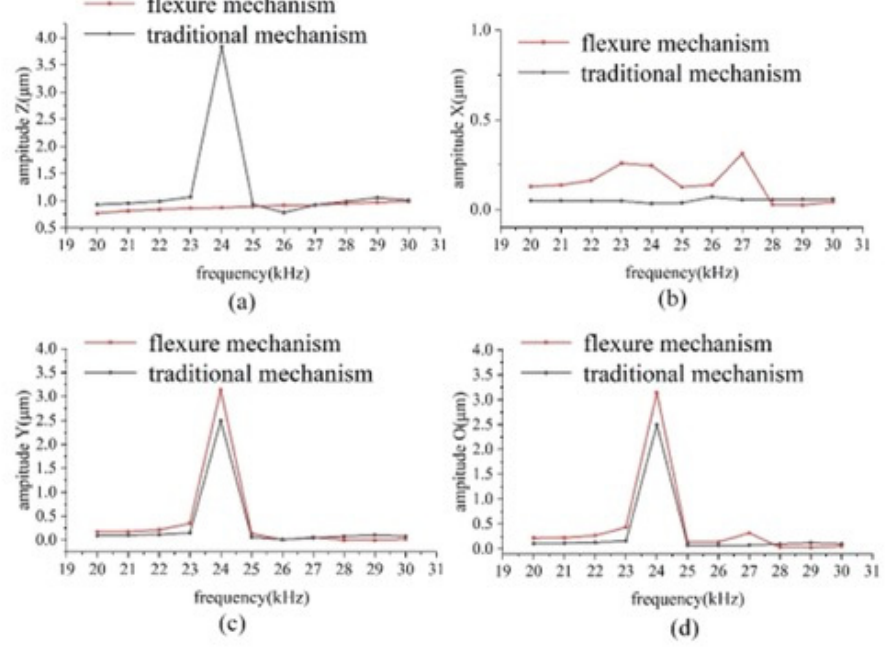
Figure 7. Vibration test of the output shaft of the microdissection device: ( a ) The frequency response curve of the vibration amplitude in the axial Z direction of the output shaft of the two structures; ( b ) the frequency response curve of the vibration amplitude in the lateral X direction of the output shaft of the two structures; ( c ) the frequency response curve of the vibration amplitude in the lateral Y direction of the output shaft of the two structures; ( d ) the frequency response curve of the vibration amplitude of the output shaft of the two structures in space. Table 5. The optimal vibration parameters of the output shaft of the two structure devices.